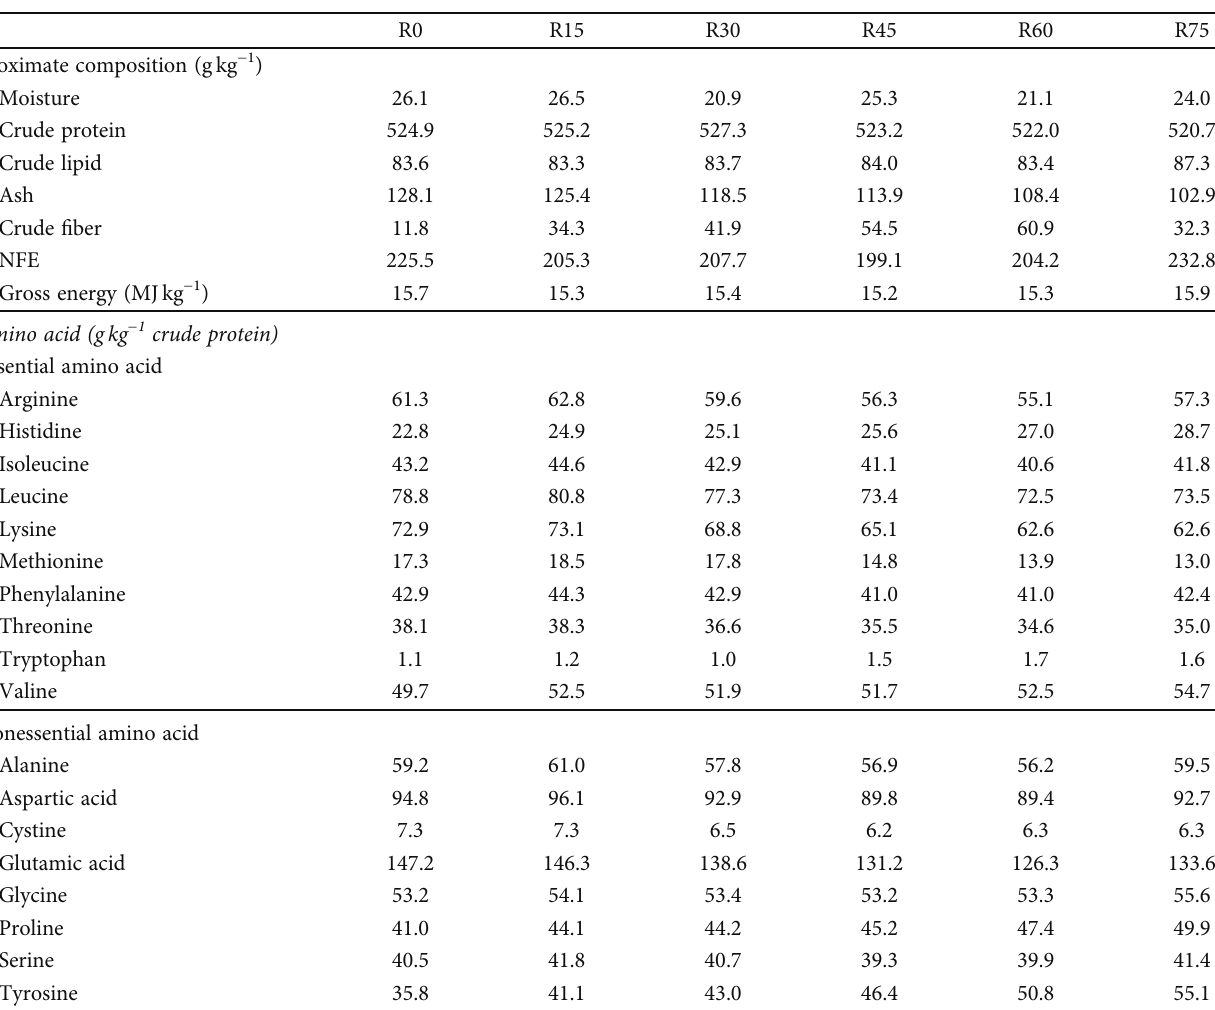
Table 3: Proximate and amino acid composition of experimental